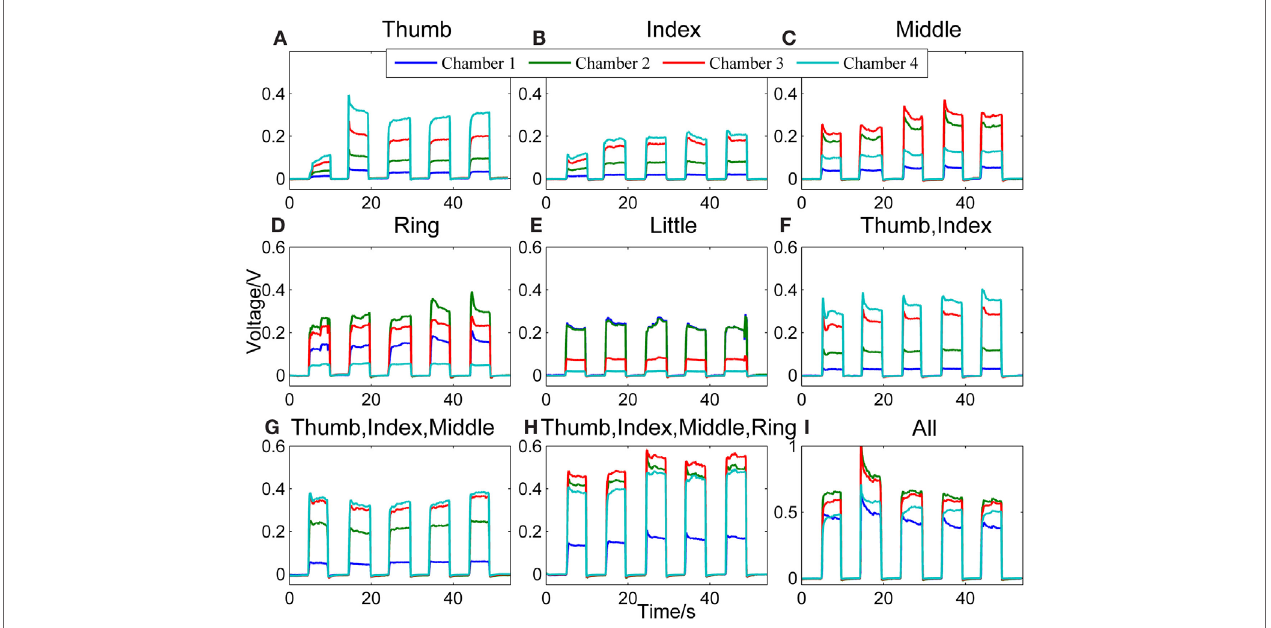
FigUre 2 | representative signal patterns for different finger actions . Signals recorded from the four chambers of the finger sensor when nine different types of finger actions were performed, which include compressing the sensor body with (a) thumb, (B) index finger, (c) middle finger, (D) ring finger, (e) little finger, (F) thumb + index finger, (g) thumb + index + middle fingers, (h) thumb + index + middle + ring fingers, and (i) all fingers, respectively.